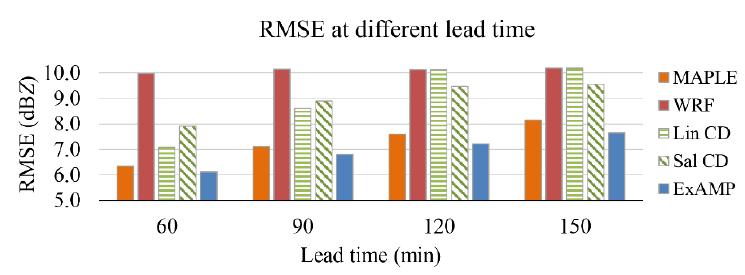
Figure 5. The root mean square errors (RMSEs) of the reflectivity predicted by MAPLE, WRF, Lin CD, Sal CD, and ExAMP at the lead times of 60, 90, 120, and 150 min, computed over the grid points with observed reflectivity exceeding 0 dB Z for the 43 periods.